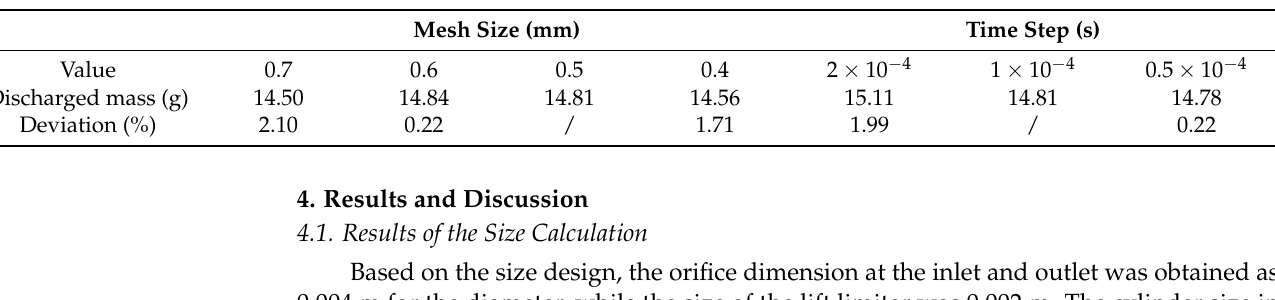
Table 3. Results of simulations under the different mesh and time